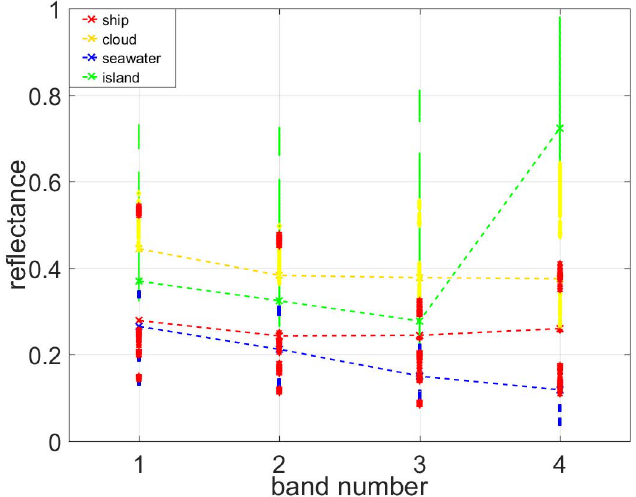
Figure 3. The reflectance values of seawater, clouds, islands, and ships collected from multispectral images in each